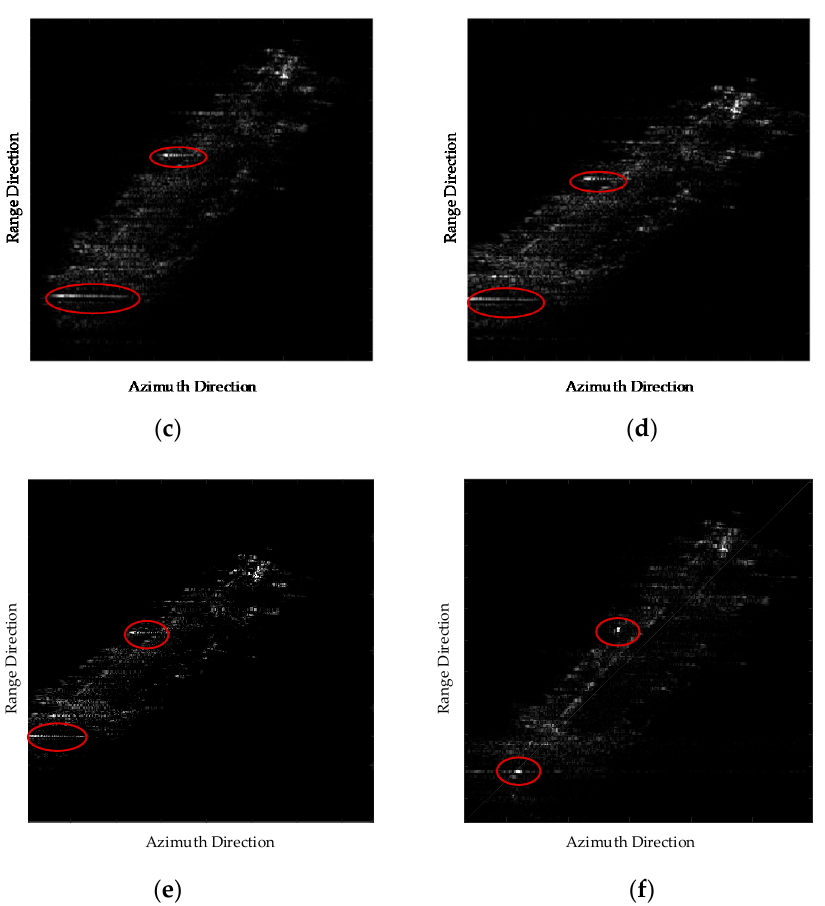
Figure 13. First case study results: ( a ) Rough imaging result of the tanker obtained by the BP integral; ( b ) Refocusing result obtained by the PGA algorithm; ( c ) Refocusing result obtained by the CS-ISAR algorithm; ( d ) Refocusing result obtained